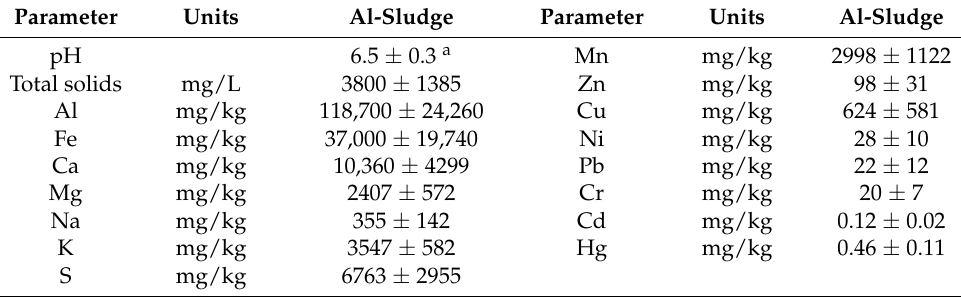
Table 1. Physicochemical composition of AlS